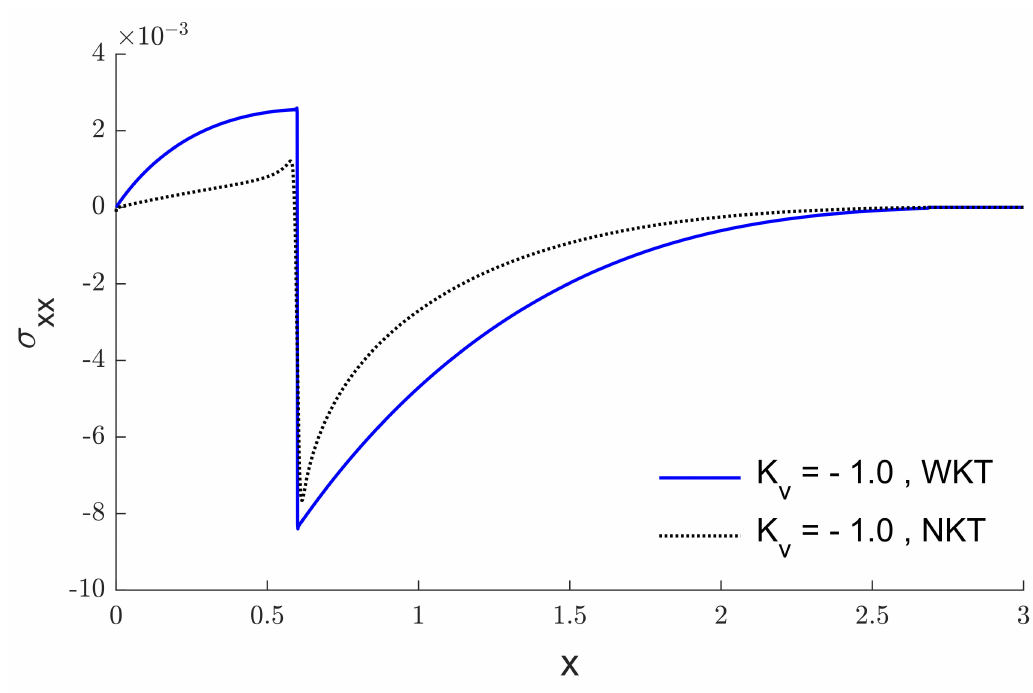
Figure 6. The stress variation with and without Kirchhoff transform when K v = − 1.